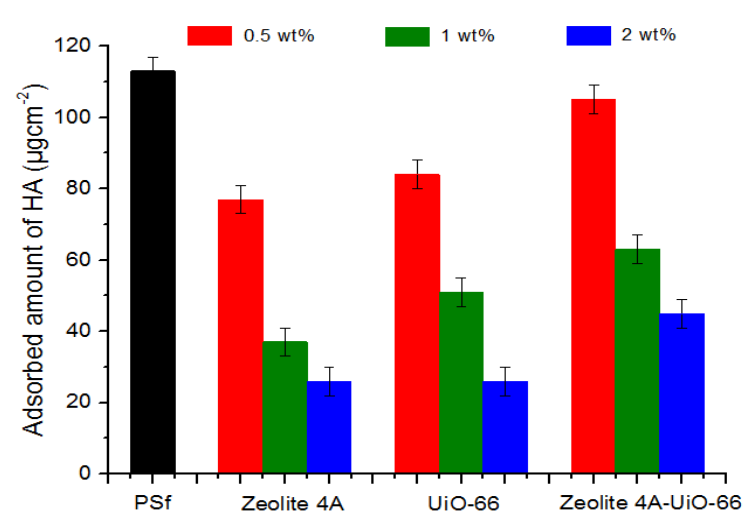
Figure 5. Adsorbed amount of humic acid on neat PSf and MMMs.